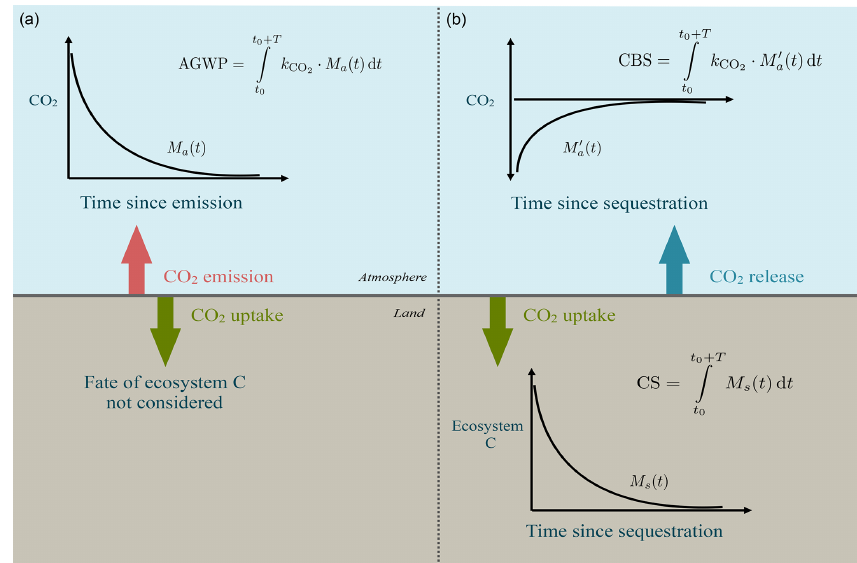
Figure 1. Contrast between current approach to quantification of climate effects of emissions and sequestration (a) , and the proposed ap- proach for sequestration (b) . Plots and equations represent the concepts of absolute global warming potential (AGWP) of an emission of CO 2 , carbon sequestration (CS), and climate benefits of sequestration (CBS). AGWP integrates over a time horizon T the fate of an instant emission at time t 0 of a gas ( M a (t) ) and multiplies by the radiative efficiency k of the gas. A similar idea can be used to define CS as the integral of the fate M s (t) of an instant amount of carbon uptake S 0 over T . The CBS captures the atmospheric disturbance caused by CO 2 uptake and subsequent release by respiration as the integral over T of the fate of sequestered carbon M (cid:48) a (t) multiplied by the radiative efficiency of CO 2